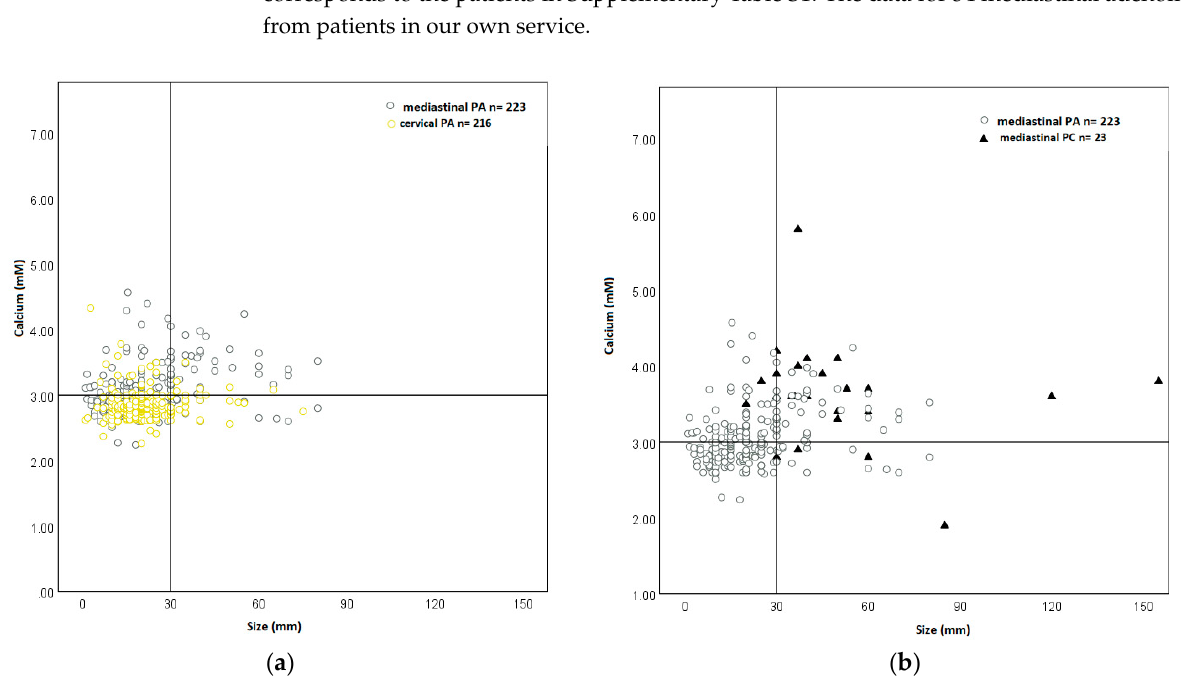
Figure 3. Scatter plot of calcium levels versus tumour size of benign ( a ) and malignant ( b ) mediastinal parathyroid neoplasms. Legend to ( a ) ( left ) cervical parathyroid adenomas been obtained from Schulte and Talat [12] and 223 mediastinal parathyroid adenomas were obtained from case reports from the literature. ( b ) ( right ), the cohort of 23 mediastinal parathyroid cancer patients corresponds to the patients in Supplementary Table S1.